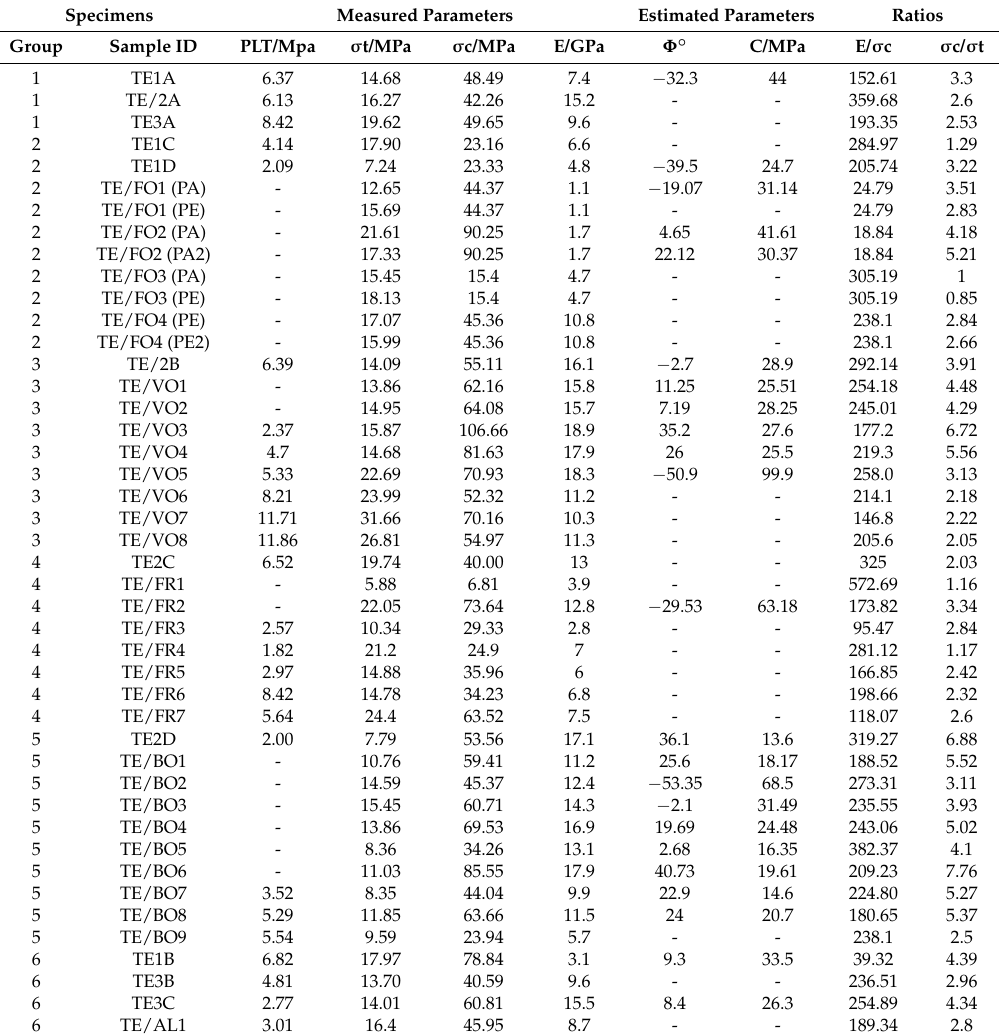
Table 5. Table with the calculated angle of internal friction and cohesion based on the UCS and ITS results